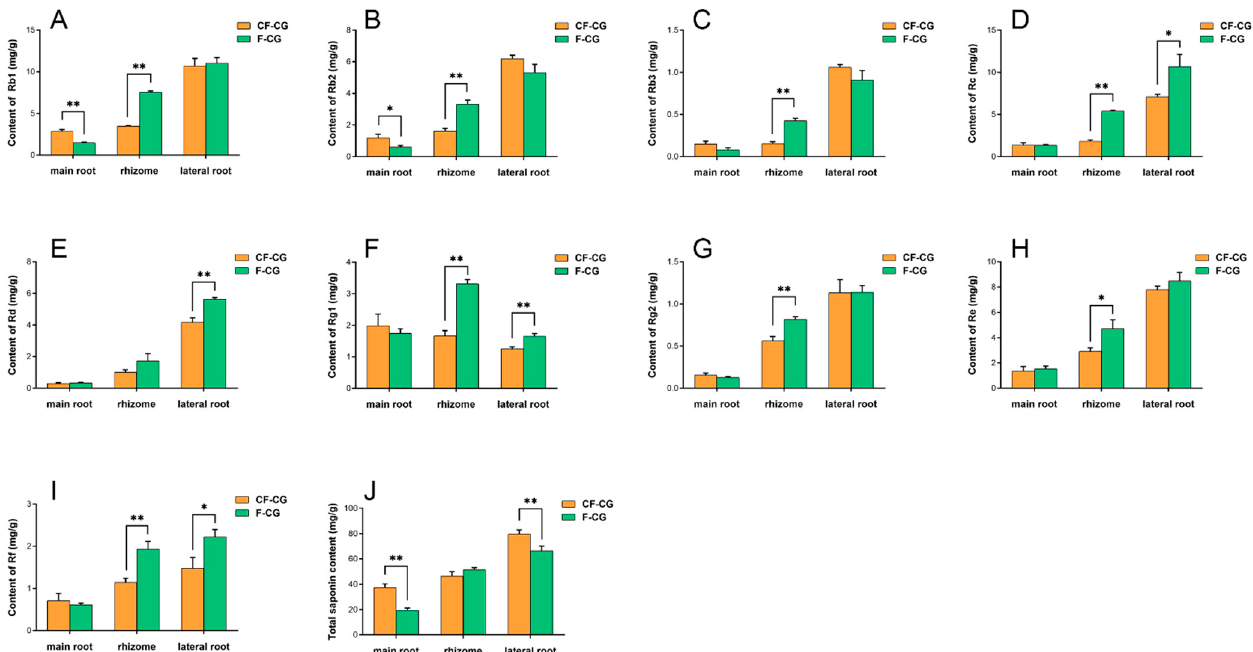
Figure 3. Determination of ginsenoside components in main roots of F-CG and CF-CG. ( A ): ginsenoside Rb1; ( B ): ginsenoside Rb2; ( C ): ginsenoside Rb3; ( D ): ginsenoside Rc; ( E ): ginsenoside Rd; ( F ): ginsenoside Rg1; G : ginsenoside Rg2; ( H ): ginsenoside Re; ( I ): ginsenoside Rf; ( J ): determination of total ginsenoside, etc. (* p < 0.05; ** p > 0.01; the significance of the difference was analyzed using t -test; vertical bars indicate the mean value ± standard deviation from three independent experiments).